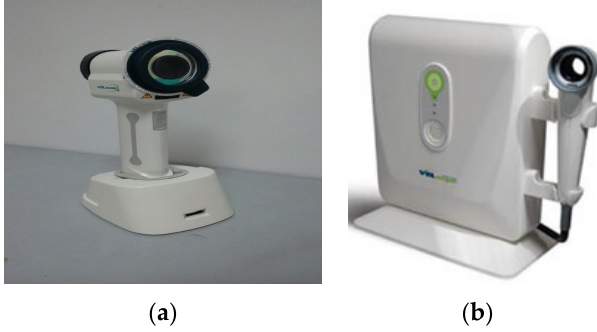
® ; ( b ) 2nd generation VELscope ®